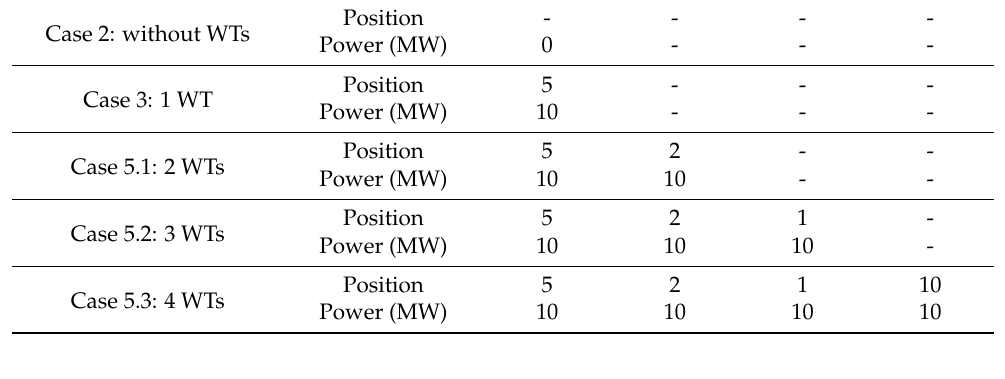
Table 3. Optimal solutions of Case 2, Case 3, and Case 5 for the IEEE 30-node system.